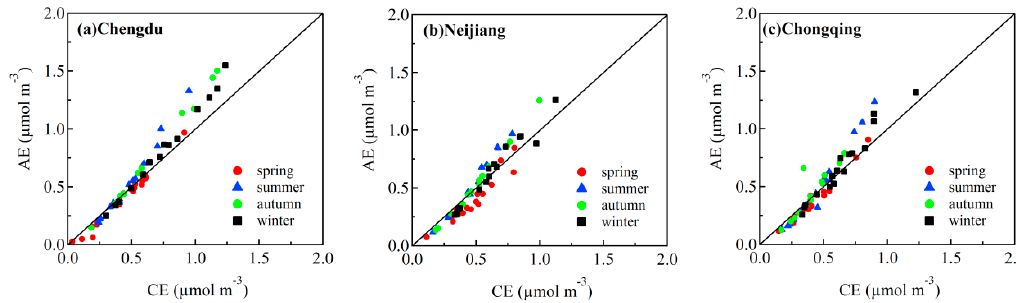
Figure 3. Scatter plots of total anions vs. total cations in ( a ) CD, ( b ) NJ, and ( c ) CQ.